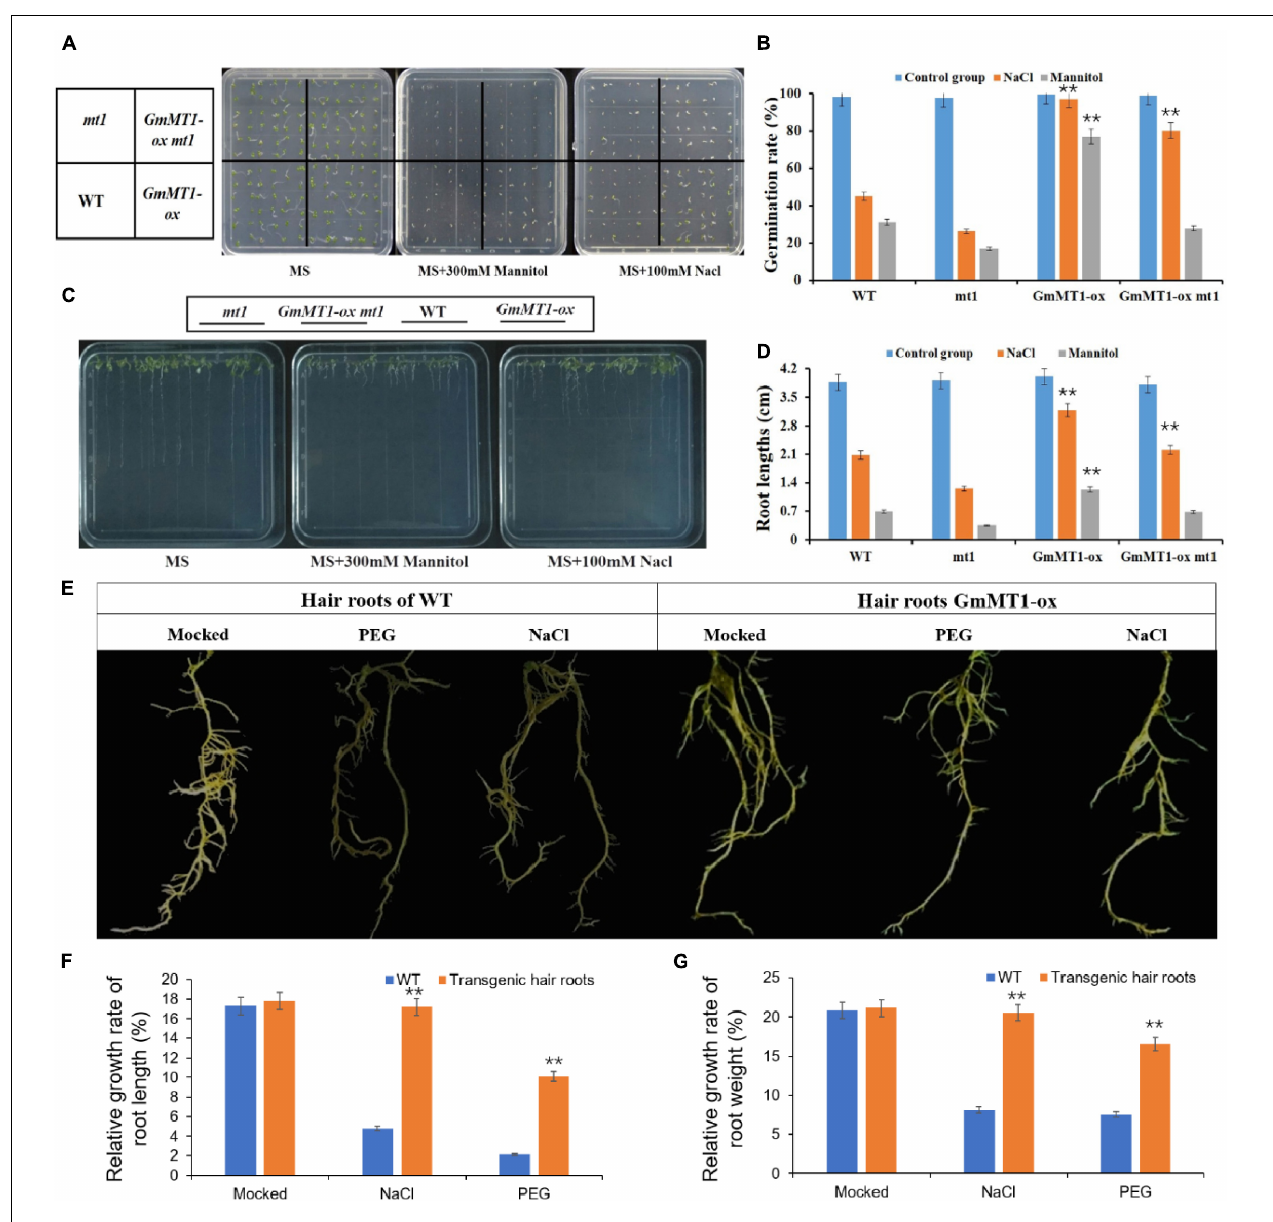
FIGURE 6 | Effects of GmMT1 overexpression on Arabidopsis and on soybean hairy roots after exposure to salt or drought stress. (A,B) Germination and (C,D) root growth of Arabidopsis Columbia-0 (WT), Arabidopsis mt1 (a mutant strain in which the Arabidopsis homolog of GmMT1 , At3G28460 , is silenced), and two T3 transgenic lines overexpressing GmMT1 ( GmMT1-ox and GmMT1-ox mt1 ) after exposure to salt (100 mM NaCl) or drought (300 mM mannitol) stress. (E) Phenotypic differences in hairy roots of transgenic and non-transgenic soybeans after exposure to salt (NaCl) or drought (PEG) stress. (F,G) Relative rates of increase in panels (F) root length and (G) root weight for non-transgenic “Dongnong50” soybeans (WT) and transgenic soybeans overexpressing GmMT1 after exposure to salt (NaCl) or drought (PEG) stress. ** indicates a significant difference between WT and transgenic or between treatment and control groups ( P < 0.01, Student’s t test). Error bars represent standard error ( n =